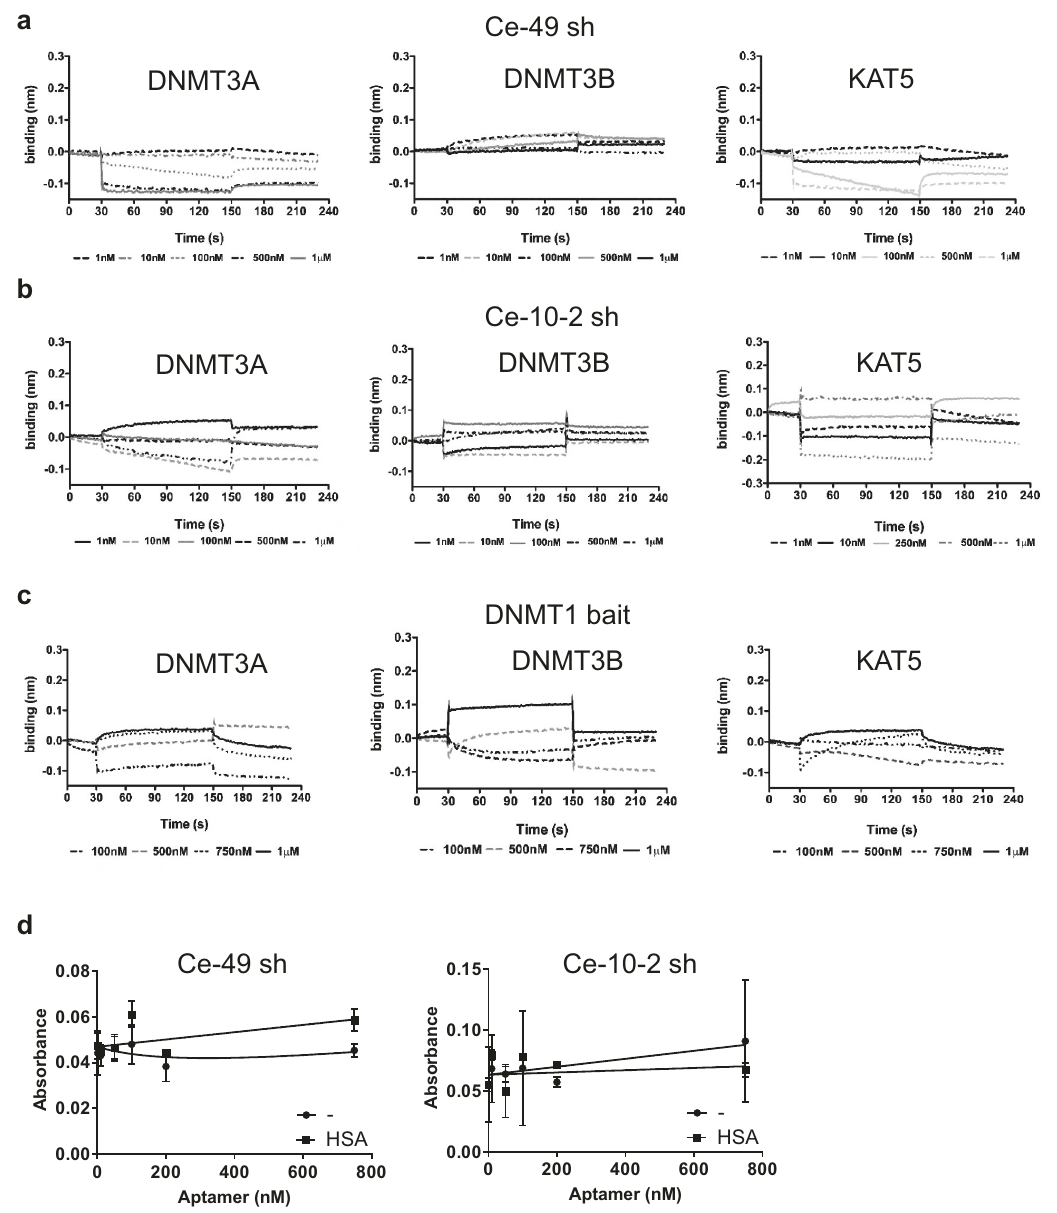
Fig.4|AptaDiRspeci fi city. Bindingmeasuredbybio-layerinterferometryofCe-49 sh( a ),Ce-10-2sh( b )andDNMT1bait( c )toDNMT3A( leftpanels ),DNMT3B( middle panels ) and KAT5 protein ( right panels ) immobilized on separate biosensors. Aptamers were tested at the reported concentrations. d ELONA assay of indicated